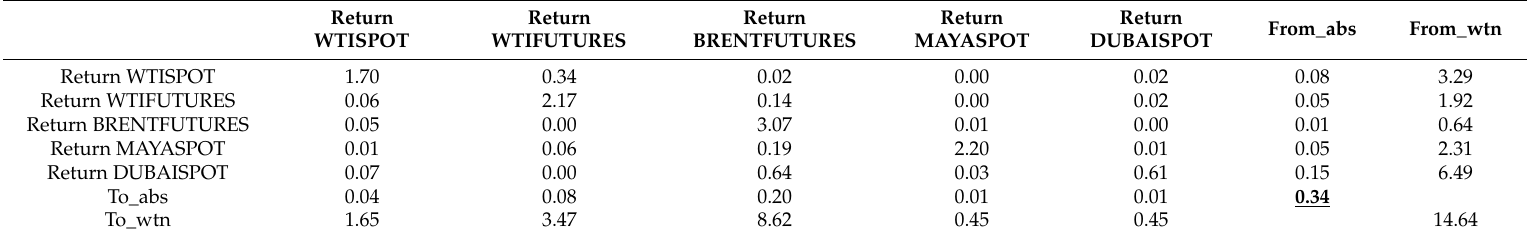
Freq L: The Spillover Table for Band: 0.15 to 0.01. Roughly Corresponds to More than 21 Days.